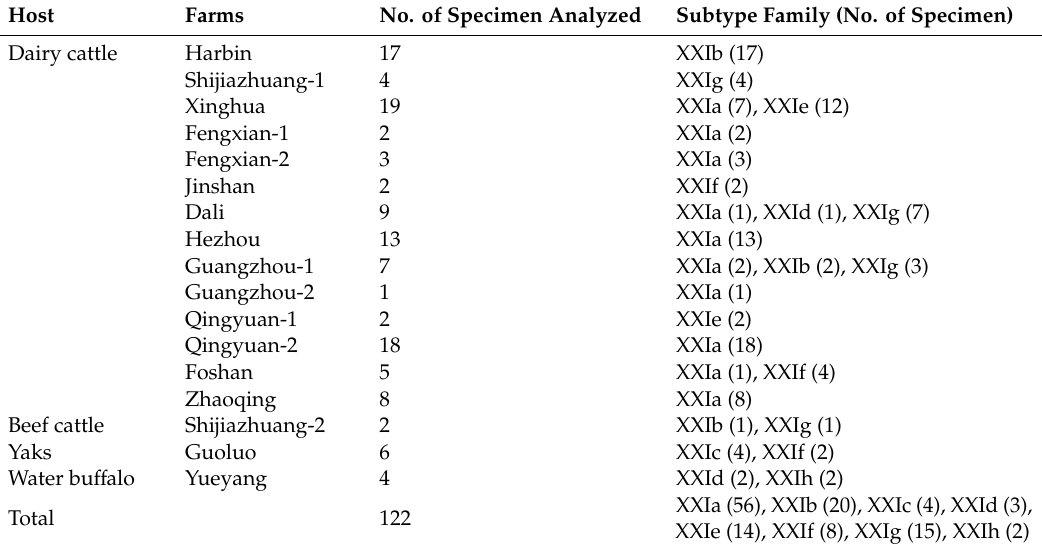
Table 1. Cryptosporidium ryanae subtypes identified in bovine animals in China at the gp60 locus. Host Farms No. of Specimen Analyzed Subtype Family (No. of Specimen)